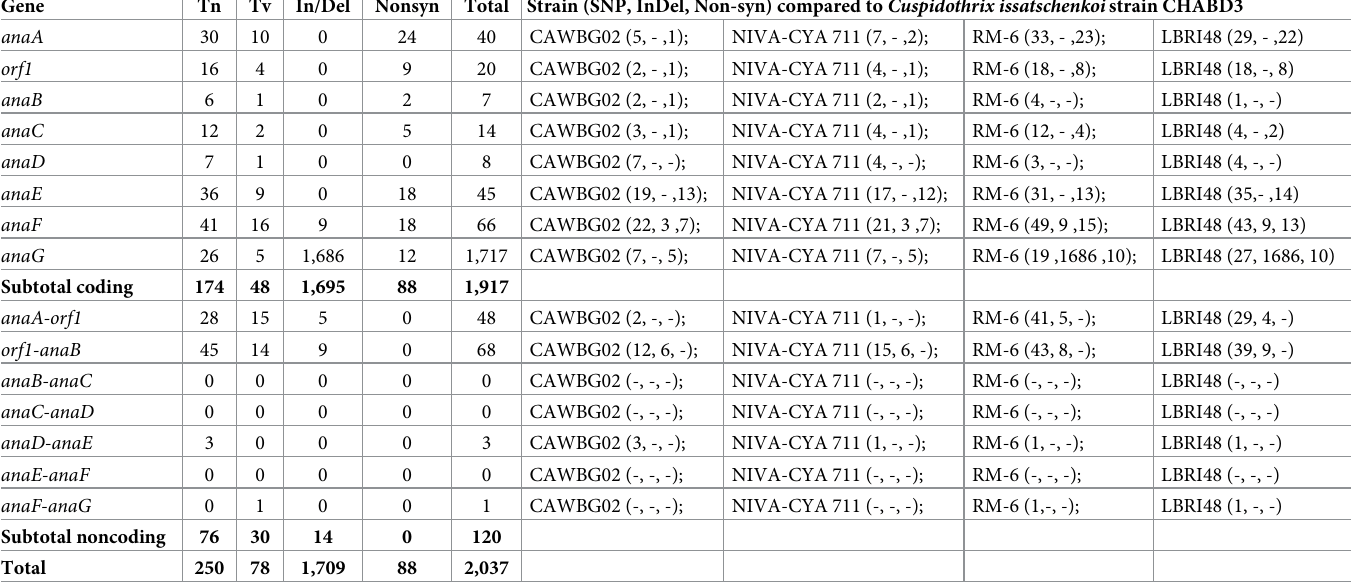
Table 3. Genes and non-coding regions in the ana gene cluster with single nucleotide polymorphisms (SNP) compared to Cuspidothrix issatschenkoi strain CHABD3 from China. Tn = Transition, Tv = Transversion, In = Insertion, Del = Deletion. CAWBG02 (New Zealand), NIVA-CYA 711 (Germany), RM-6 (Japan), LBRI48